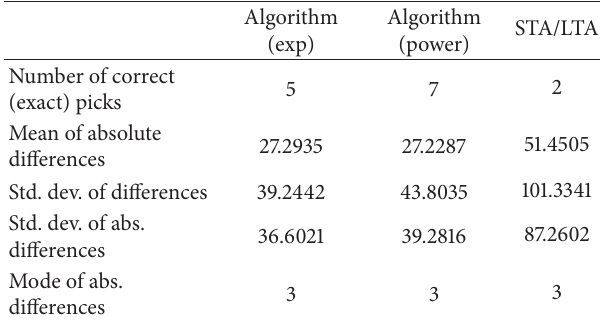
Table 1: Comparison between algorithms based on second statisti- cal moment and STA/LTA